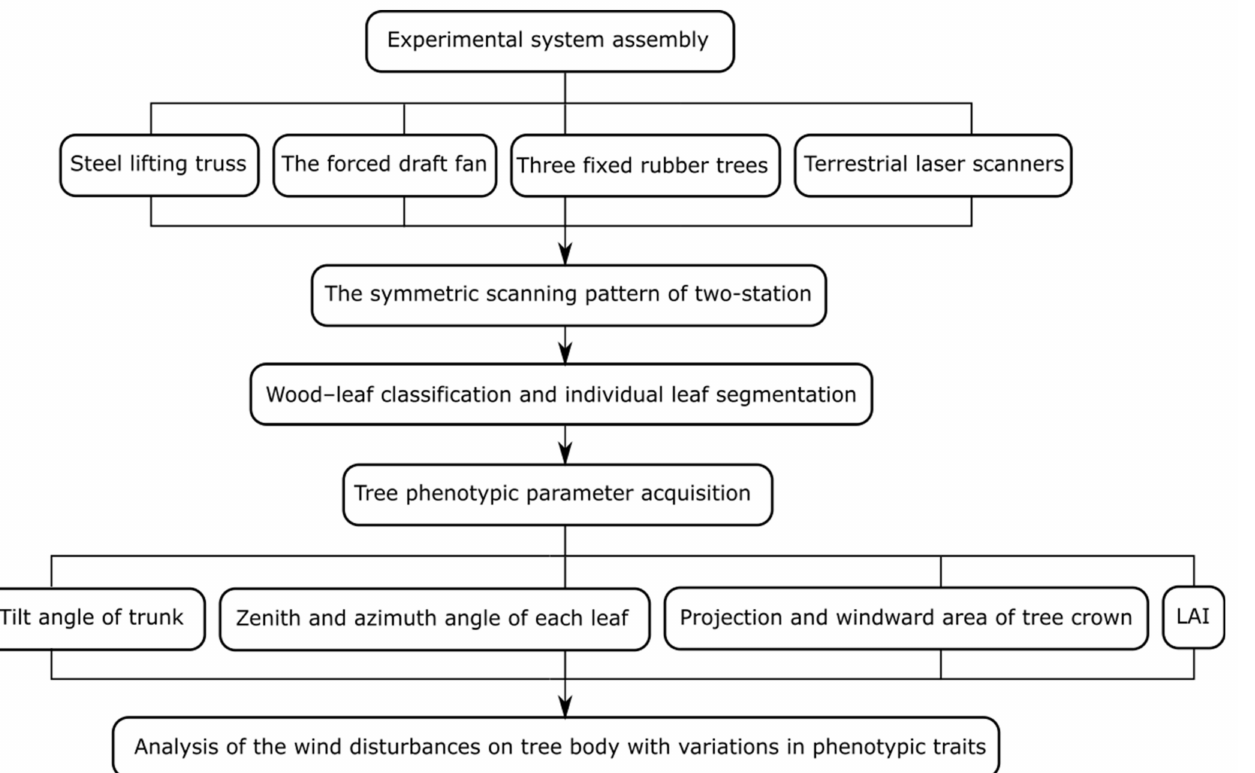
Figure 1. An overview of the workflow of the approach developed in the present